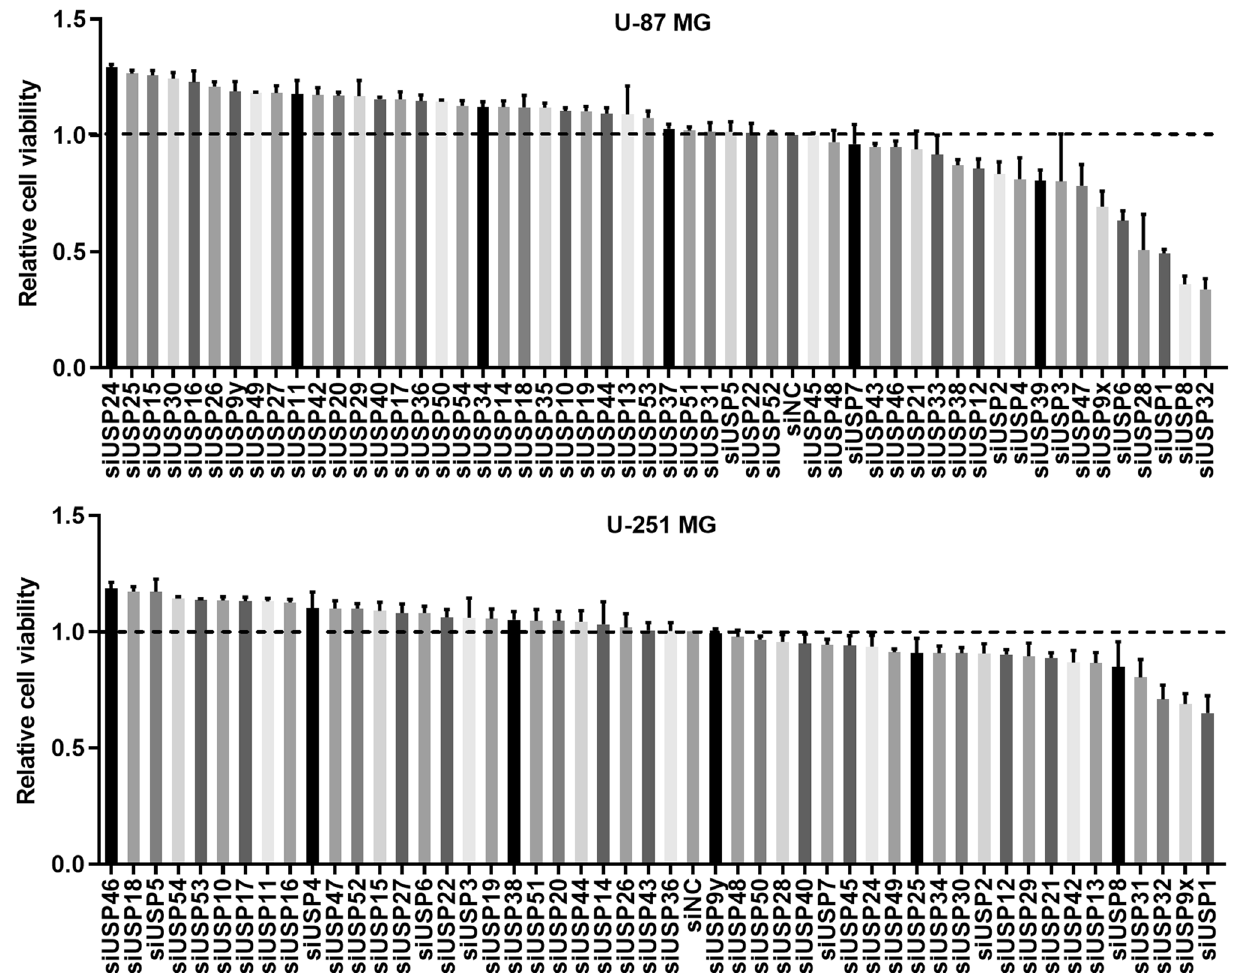
Figure 1. High content screening based on cell viability to screen USPs may function in glioblastoma. Data are represented as mean ± standard deviation (SD) of three biological